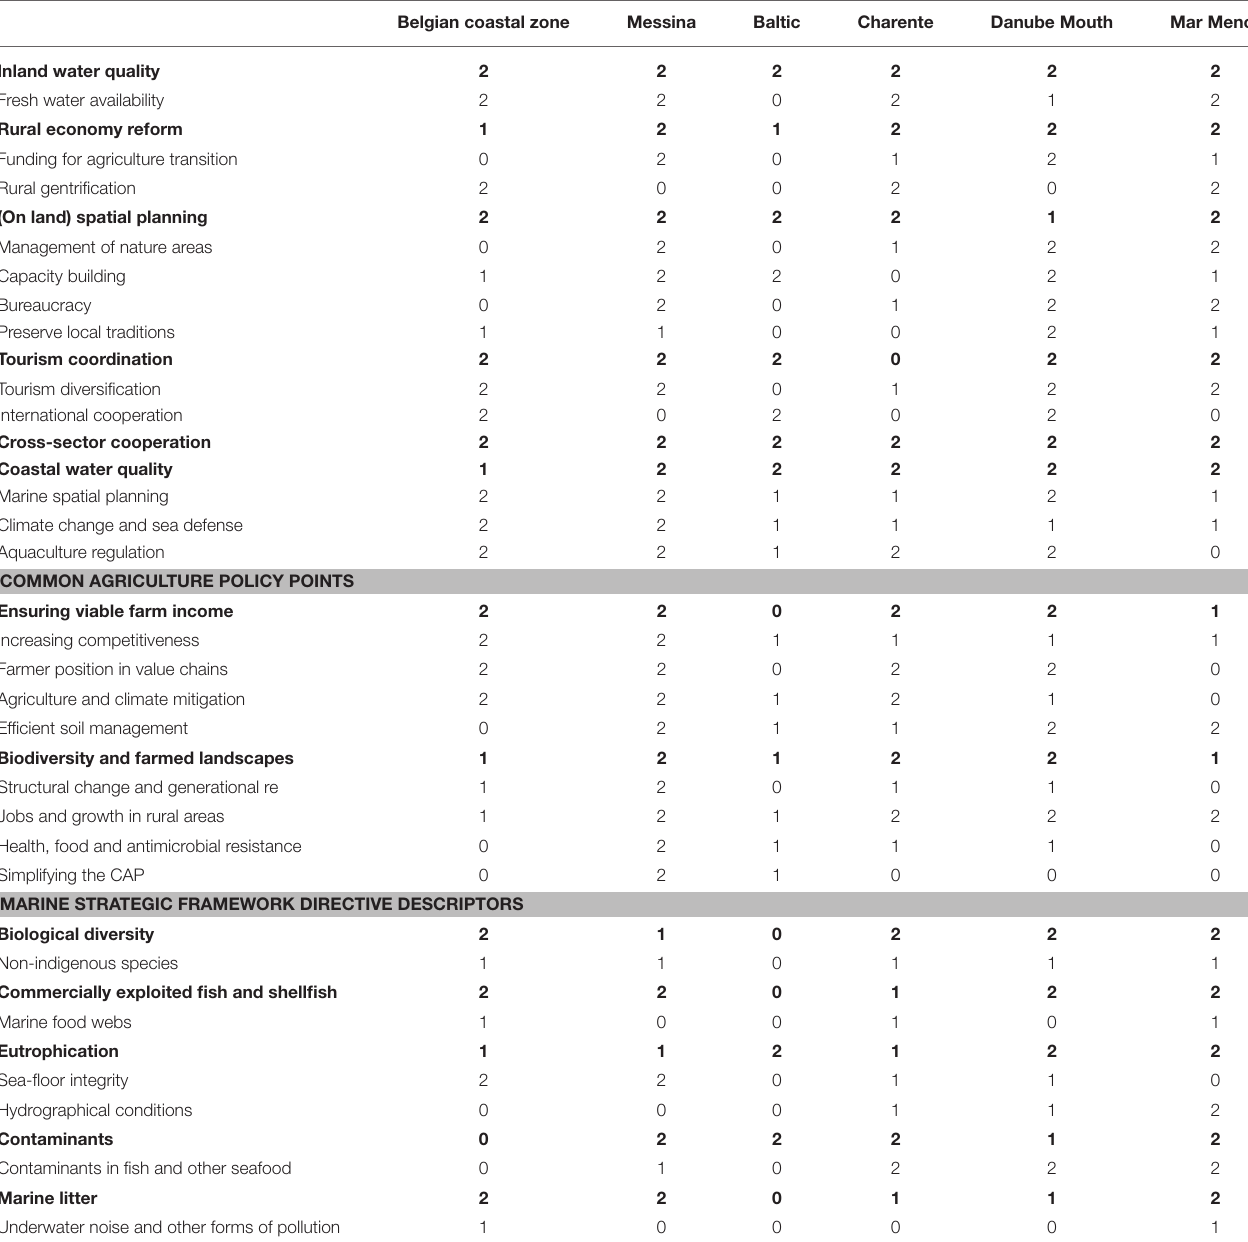
TABLE 3 | The themes in column 1 of the table are first themes we extracted based on the deliverable itself and the workshops in the six case areas. Belgian coastal